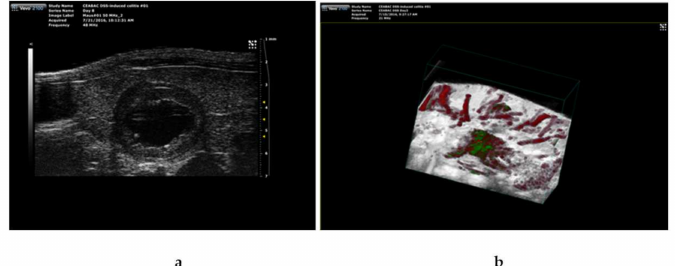
Figure 5. Photoacoustic imaging combined with ultrasound imaging was used to verify the severity of inflammation and ICG targeting to the site of inflammation in DSS-treated mice. The mice ( n =3) were treated with 4% dextran sodium sulfate (DSS) for four days before the addition of ICG-loaded SM-liposomes via tail vein injection (125 µ L 20 mM total lipid in PBS). A representative in vivo image from the colon of the DSS treated mouse using ultrasound ( a ) and photoacoustic visual, sonic device ( b ) are shown. ICG signal detected by spectral unmixing is presented in green, and red represents the hemoglobin signal in the PA